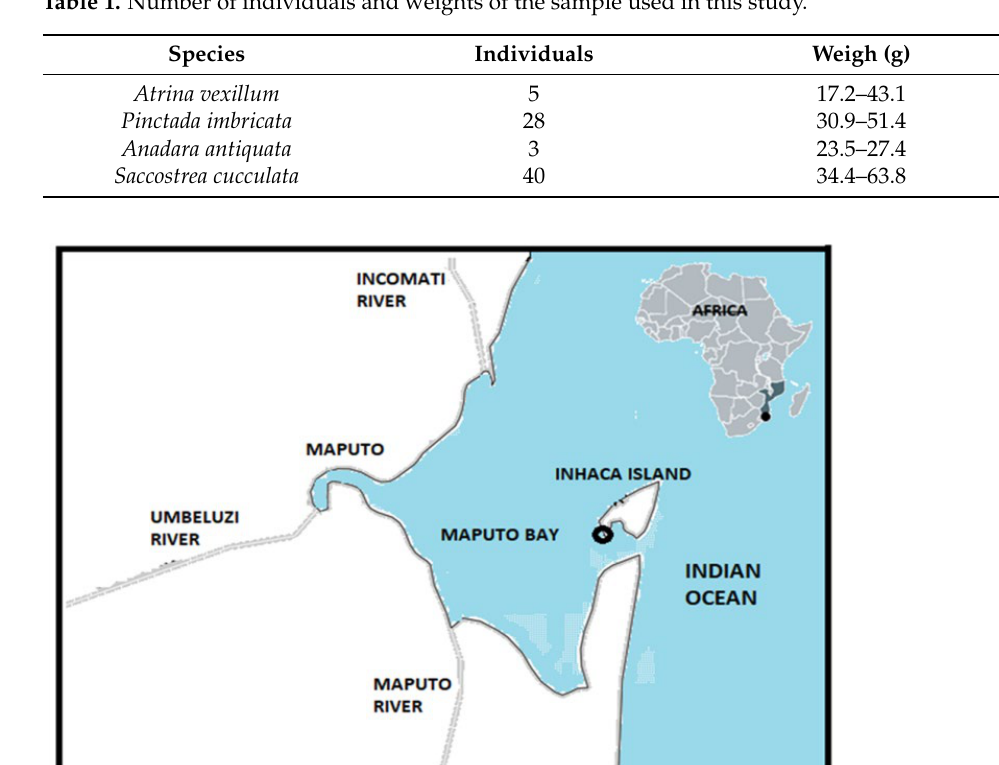
Table 1. Number of individuals and weights of the sample used in this study.